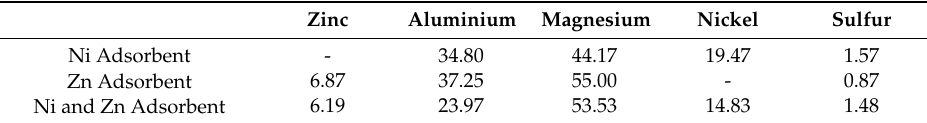
Table 4. Relative percent abundances of species from